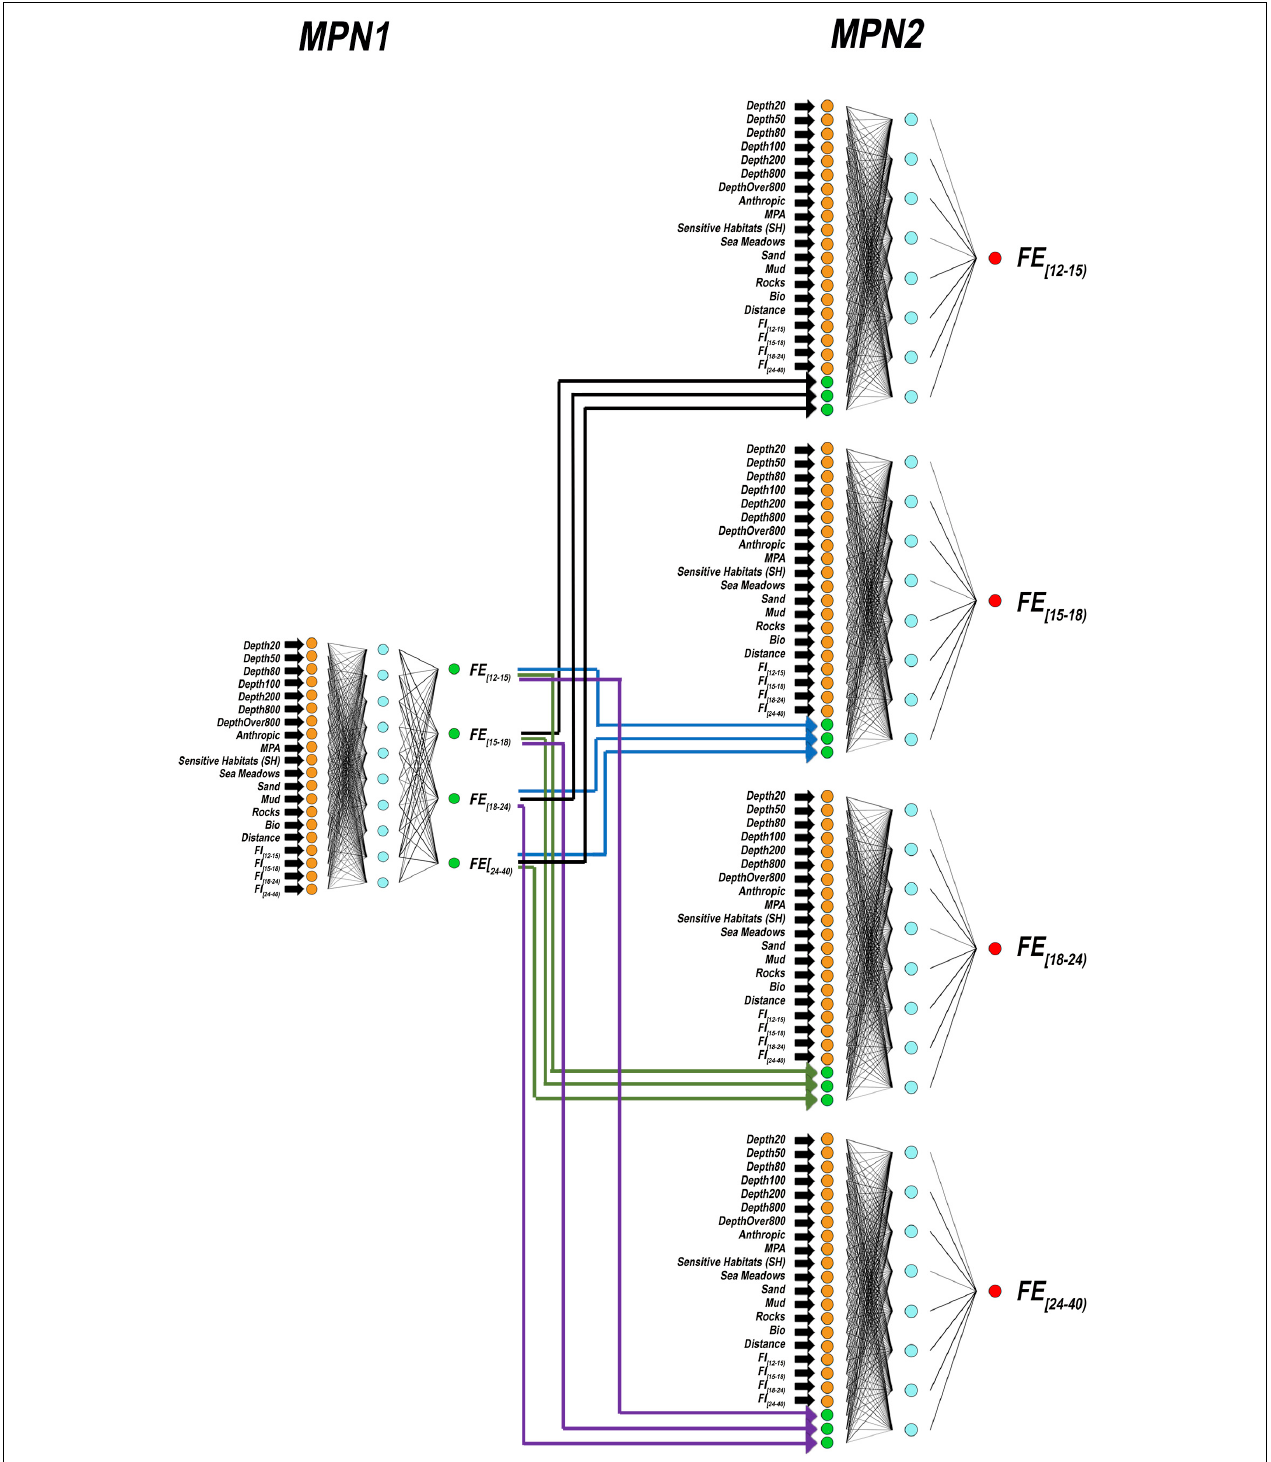
FIGURE 6 | Structure of the cascaded multilayer perceptron network used in this study. The names of the input variables are shown on the left side. The MPN in the first layer has four output neurons, one for each FE c , l of a given l length class. The MPNs in the second layer has one output neuron each, since they processes FE c , l from MPN in layer one by considering interactions between fleet segments. Different colors of input neurons are used to emphasize the fact that MPNs in the second layer reuse input data for MPN in the layer one (orange) plus their outputs (green). The neurons in the hidden strata are represented in cyan. Final output neurons are in